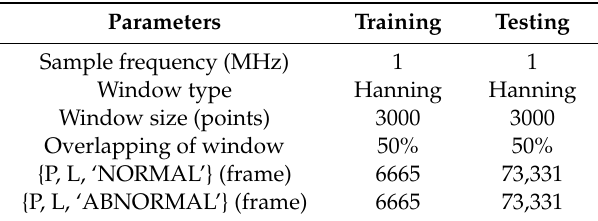
Table 4. Dataset